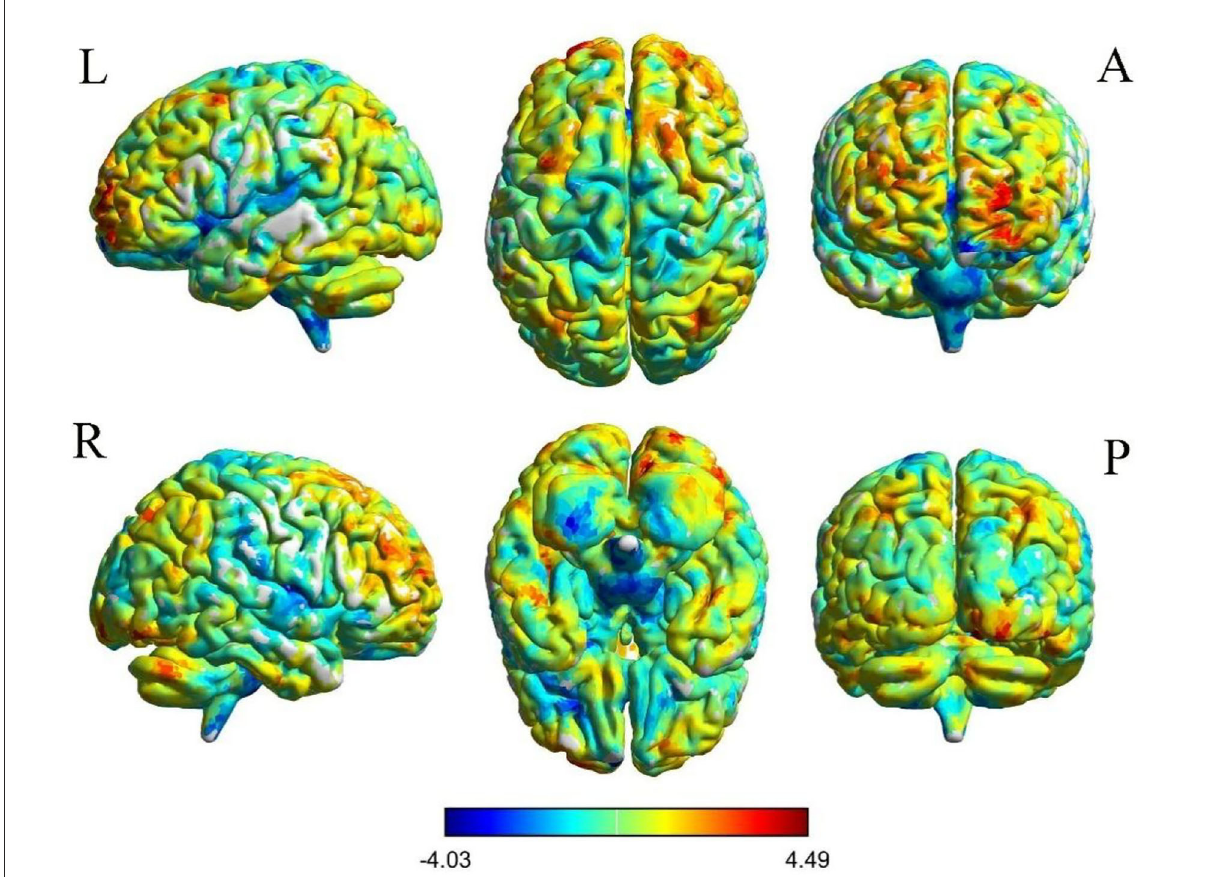
FIGURE3 Voxelwise comparison of FC between participants in the PACG and HC groups based on the right thalamus seed (voxel-level P < 0.05, AlphaSim corrected). Color bars indicate t-scores; warm colors indicate areas where the FC value in PACG is greater than that in HCs, while cold colors indicate the